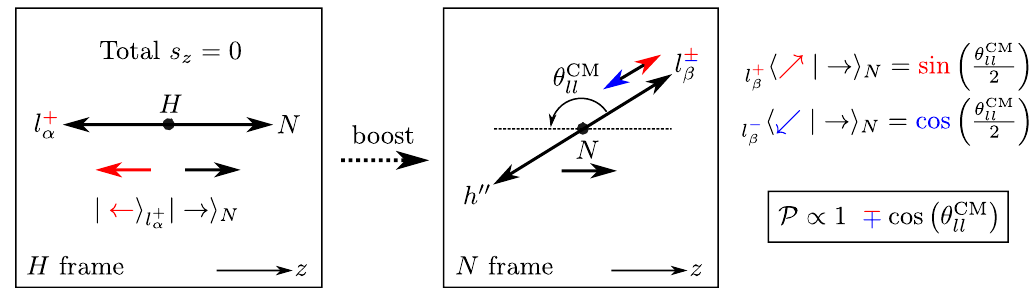
Figure 3. This sketch explains the origin of the di(cid:11)erent angular correlations for LNC and LNV processes. For simplicity, here we consider two-body primary and secondary decays involving only pseudoscalar mesons, and the masses of the charged leptons and of h are neglected. For de(cid:12)niteness, 00 the charge of the primary lepton | which is produced inside the target and thus inaccessible | is also (cid:12)xed to +. Since the HNL is a Majorana fermion, the secondary lepton l can have either charge. (cid:12) However, due to angular momentum conservation, the lepton l + and the HNL N are produced with (cid:11) opposite spin projections in the rest frame of the heavy meson H . Because of chiral suppression (which is more e(cid:11)ective for light fermions), the charge of the primary lepton is correlated with its spin (e.g. in the massless limit, l + has helicity + 1 ) and hence with the HNL spin. For the same (cid:11) 2 reason, the angular distribution of the decay products of the resulting HNL spin eigenstate (which is una(cid:11)ected by a boost along the quantization axis) will therefore depend on the secondary lepton charge. The very same formula for the probability P also holds for CP -conjugated channels, with the + sign for LNC and the (cid:0) sign for LNV. The general case (massive, with two- or three-body primary decay) is discussed in section